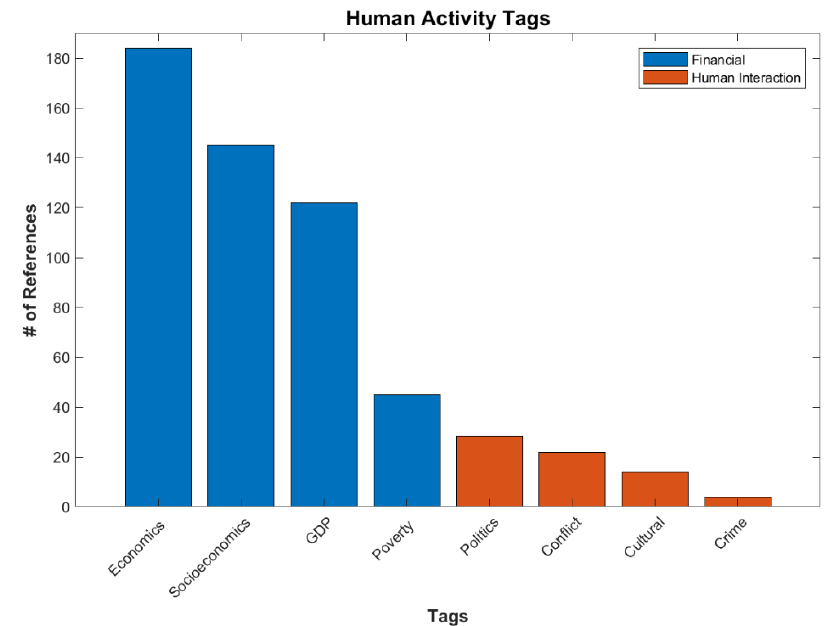
Figure 7. Number of references for various tags under Applications/Human Activity.